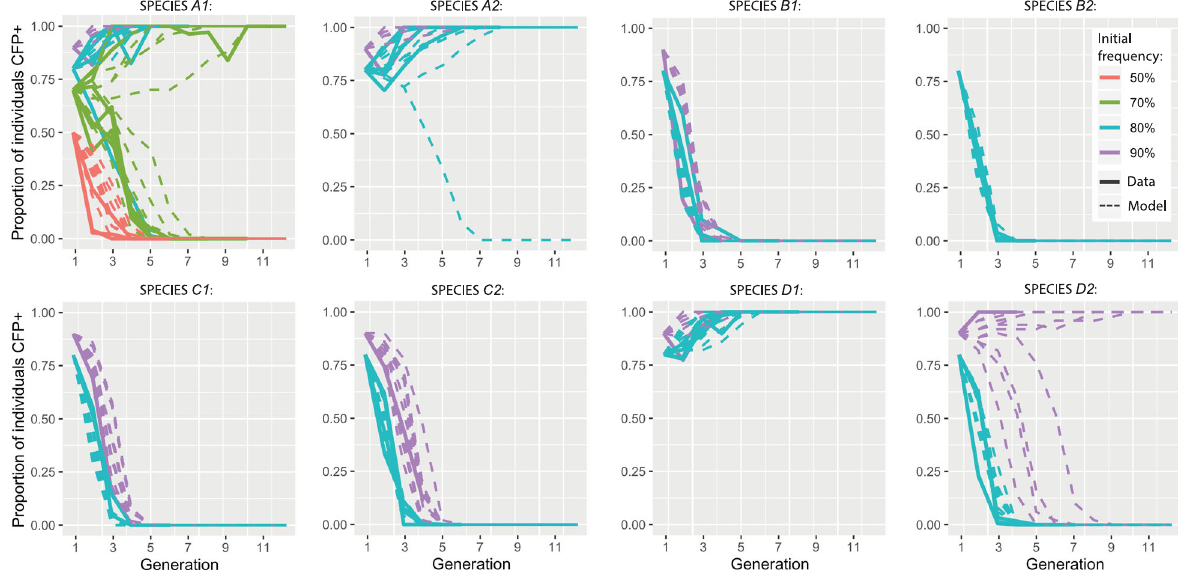
Fig. 4 Population experiments and model fi ts for eight SPECIES demonstrating threshold-dependent population replacement. Population experiments mated SPECIES individuals with WT individuals, producing fi rst generation SPECIES population frequencies of 50, 70, 80, and 90% for system A1 ; 80 and 90% for systems A2 , B1 , C1 , C2 , D1 , and D2 ; and 90% for system B2 . Results are shown as solid lines, while fi tted model predictions are dashed lines. Observed data are consistent with fi tness costs of SPECIES strains relative to WT (Supplementary Table 6). Ten stochastic model predictions are shown for each release frequency, assuming a population size of 50. Proportion of individuals CFP + represents the percentage of SPECIES individuals at each generation. Source data are provided as a Source Data fi